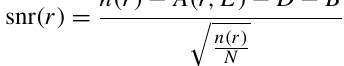
is the first approxi- ref